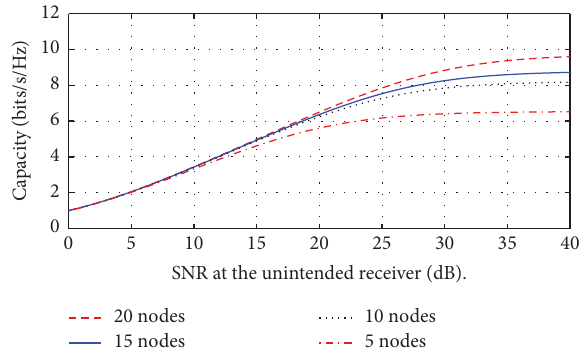
Figure 14: Capacity comparison: unintended receiver at ( − 130 degrees azimuth, 60 degrees elevation).